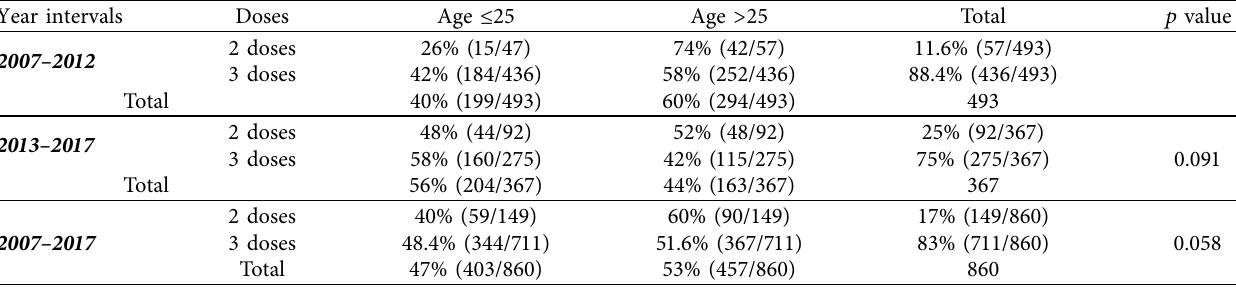
Table 1: Distribution of the human papilloma virus vaccination for women and their adolescent girls attending the Women’s Health Center (WHC) of the American University of Beirut-Medical Center (AUBMC) 2007–2017.